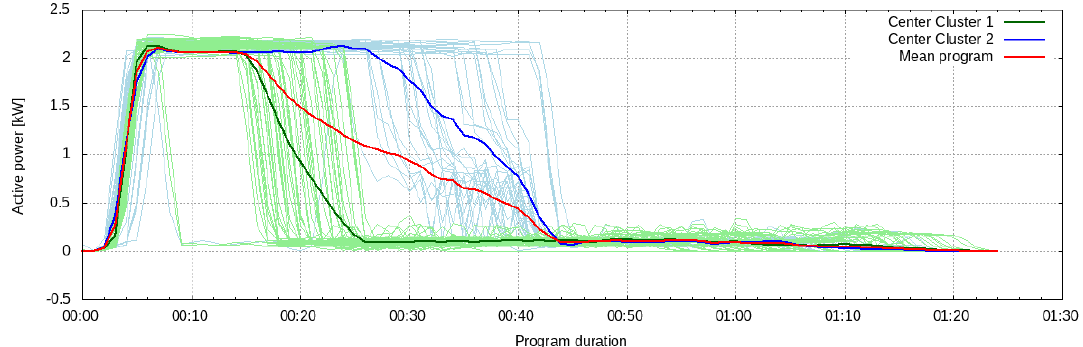
Figure 9. Clustered washing programs and their corresponding cluster centers. The mean program used for prediction is computed from the cluster centers